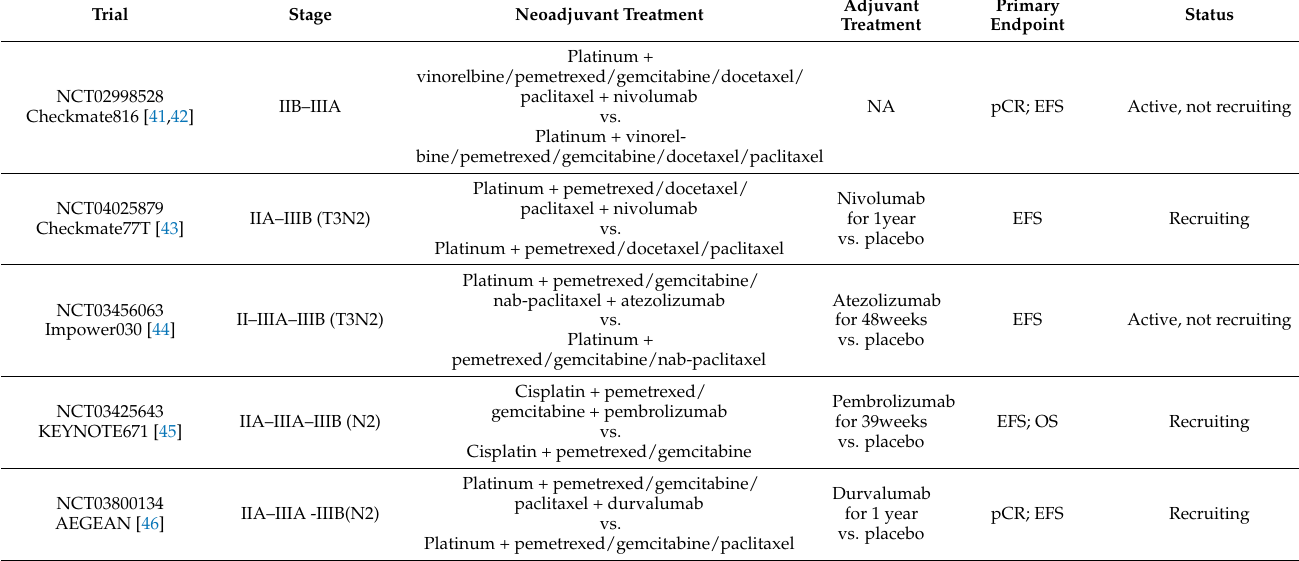
Table 2. Ongoing neoadjuvant phase III clinical trials with chemotherapy and immunotherapy. pCR: pathological complete response; EFS: event-free survival; OS: overall